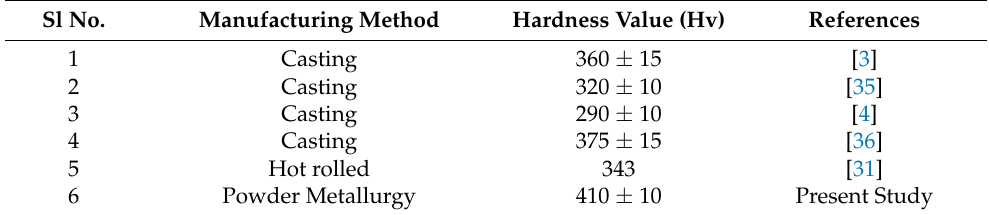
Table 4. Comparison of hardness values obtained for different valve steel made of 21-4N material. Sl No.